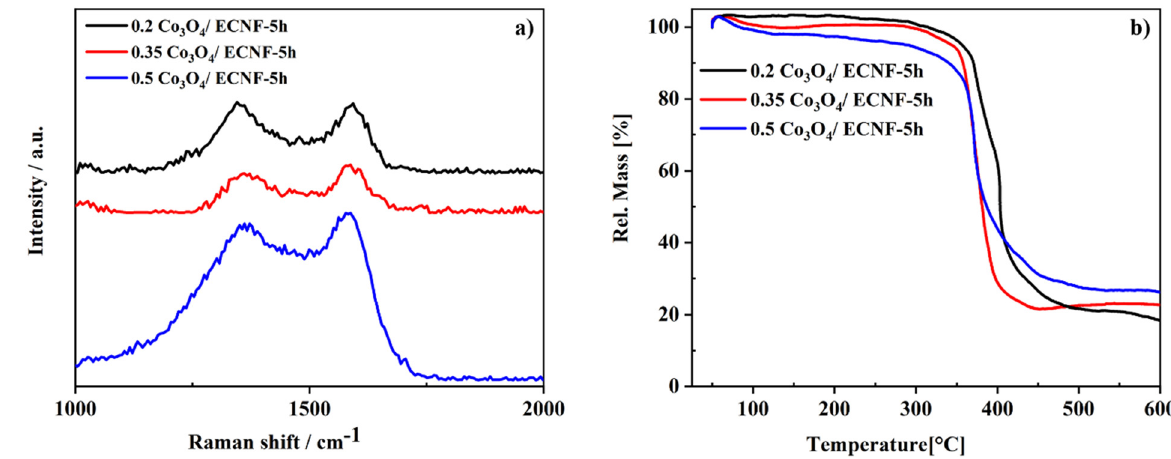
Figure 3: ( a ) Raman spectra and ( b ) TGA of Co 3 O 4 /ECNF nanocomposites with di ff erent amounts of